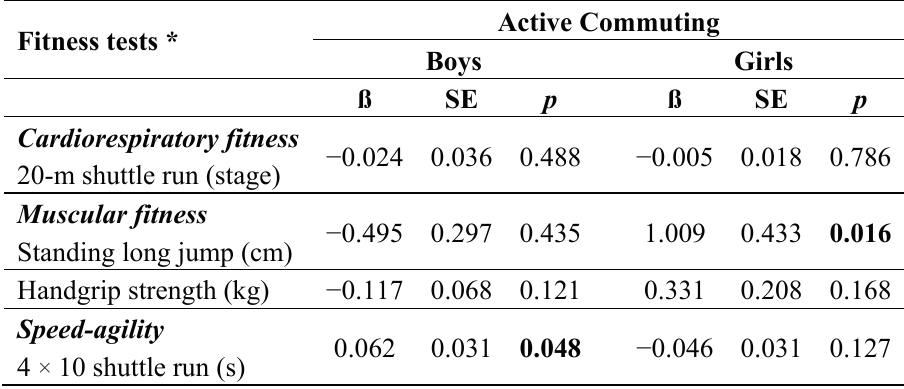
Table 2. Regression analysis (value of the unstandardized beta and standard error (SE)) for active commuting to school (expressed in total number of active travels to and from school per week) and fitness tests, adjusting for age, BMI, and distance. Active Commuting Fitness tests * Boys Girls ß SE p ß SE p Cardiorespiratory fitness − 0.024 0.036 0.488 20-m shuttle run (stage) − Standing long jump (cm)